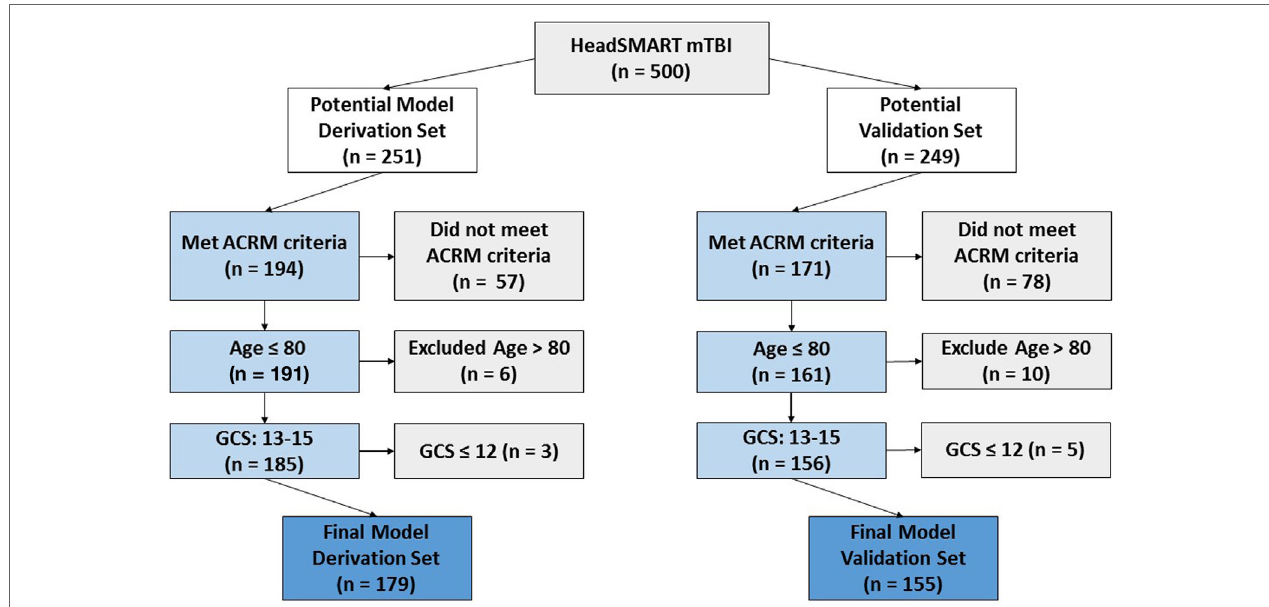
FigUre 1 | Flow diagram demonstrating the criteria for HeadSMART mild TBI (mTBI) patient selection and effect on sample size for the model derivation and validation sets. Final model set numbers also reflect the removal of a small number of samples that did not pass quality control in repeated assay